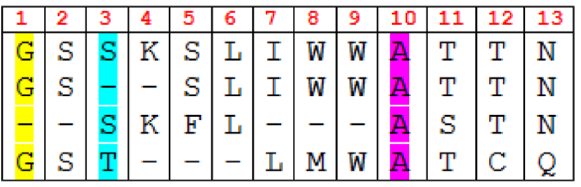
Fig. 2. A result set to explain entropy based diversity on amino acid